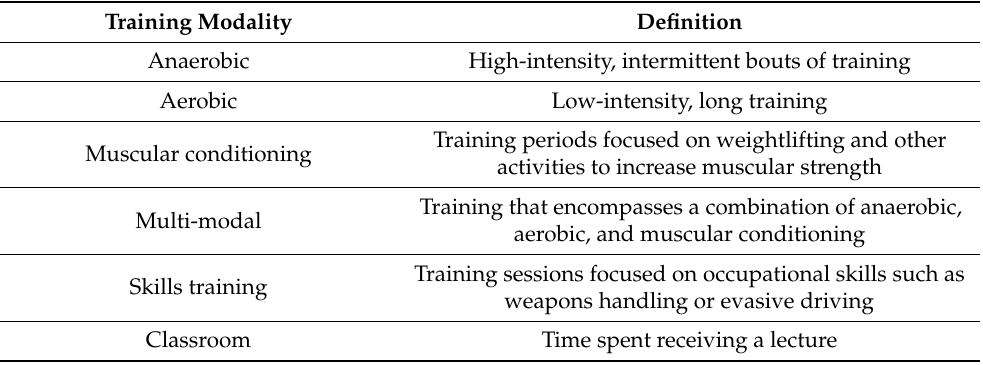
Table 1. Training modality